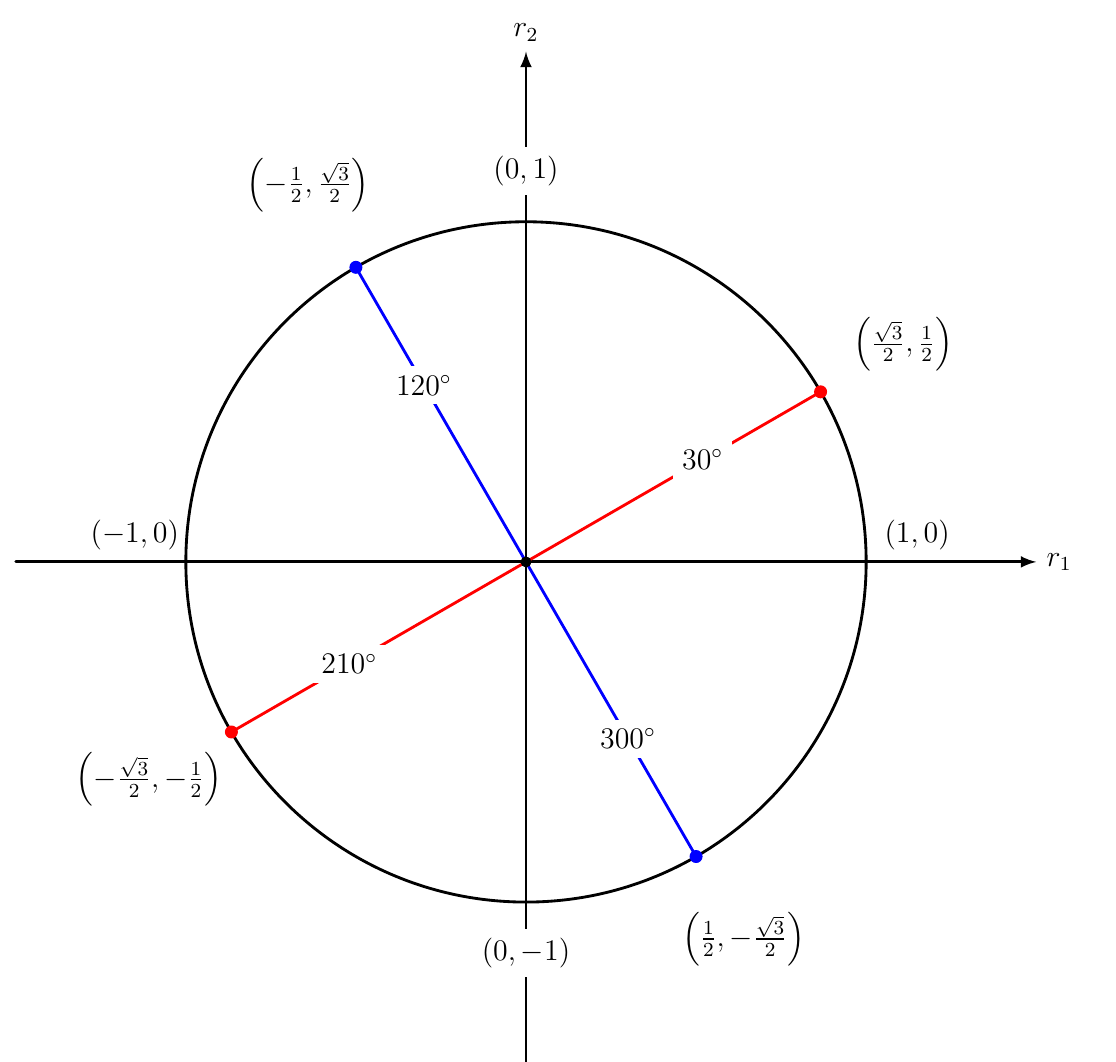
Figure 4. Depiction of Minkowski pairs on a circle. The circle is split into four quadrants and two distinct Minkowski pairs are shown lying in different quadrants. The red dots show a Minkowski pair solution r = ( √ 3 / 2 , 1 / 2) and ¯ r = ( −√ 3 / 2 , 1 / 2), which lies in the first and third quadrants of the − circle, while the blue dots show a Minkowski pair solution r = ( 1 / 2 , √ 3 / 2) and ¯ r = (1 / 2 , −√ 3 / 2), − which lies in the second and fourth quadrants of the